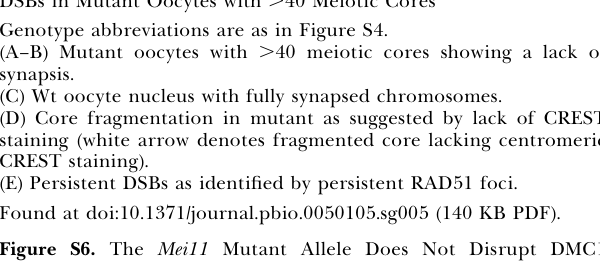
Figure S1. Mei11 Is a Mutant Allele of Dmc1 (A) Positional cloning of Mei11. Schematic representation of mouse Chr 15, showing the relative location of MIT markers used in genetic mapping (small circles) and the number of recombinants/total backcross progeny genotyped. (B) Sequence traces of Dmc1 RT-PCR products. Noncoding strand is shown. Mei11 contains two adjacent nucleotide changes, resulting in double peaks in the heterozygote (marked by bracket; homozygotes cannot be generated due to male sterility). (C) DMC1 protein structure. A, B, L1, and L2 represent amino acid sequences encoding Walker Motif A, Walker Motif B, and disordered loop regions L1 and L2, respectively. The asterisk indicates the location of the A272 . P mutation in DMC1 Mei11 , which encodes the amino acid immediately proximal to the L2 loop. Figure S2. Mutant Zygotene-Stage Spermatocyte Nuclei Contain Normal Levels of RAD51 Foci Wt (A) and mutant (B–C; of indicated genotypes) spermatocyte surface–spread nuclei were colabeled with antibodies against SYCP3 (red) and RAD51 (green). þ , wt; (cid:3) , Dmc1 (cid:3) ; Mei11, Dmc1 Mei11 . Found at doi:10.1371/journal.pbio.0050105.sg002 (120 KB PDF). Figure S3. Decreased DMC1 Foci in Mutant Spermatocytes Surface-spread spermatocyte chromosomes were colabeled with antibodies against STAG3 (a component of the meiotic cohesin core that coincides with lateral elements of the SC) and DMC1 . þ , wt; (cid:3) , Dmc1 (cid:3) ; Mei11, Dmc1 Mei11 . Figure S4. Dmc1 Mei11 Mutant Females Have Reduced Numbers of Primordial and Primary Follicles The graph shows ovarian follicle counts ( y -axis) from both ovaries of 6-wk-old mutant and wt control littermates as described in Materials and Methods. The types of follicles are indicated on the x -axis. Mei11 ¼ B6 (cid:3) Dmc1 Mei11 / þ ( n ¼ 5 ovaries from three females; shown is the